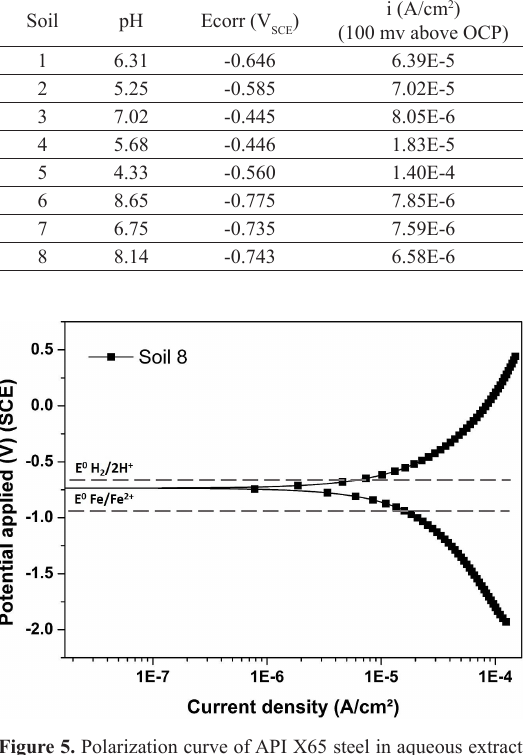
Figure 5. Polarization curve of API X65 steel in aqueous extract of Soil 8.